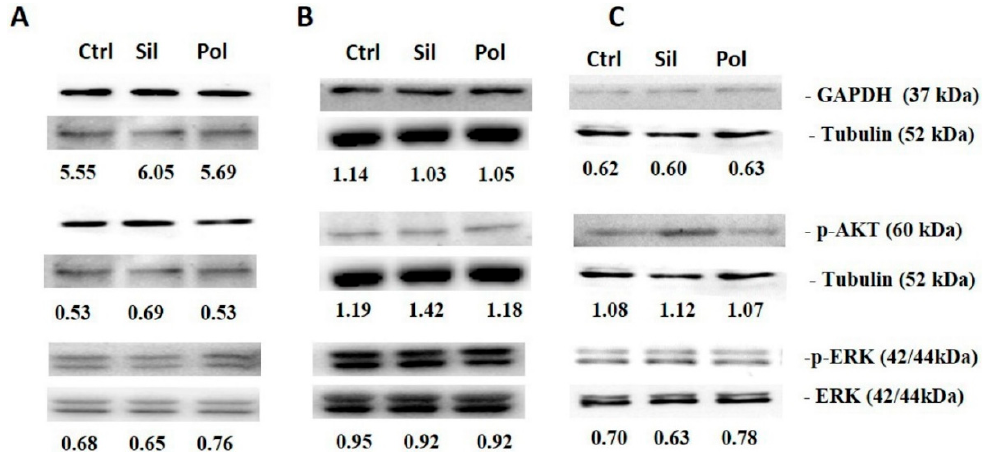
Figure 9. Nanoparticles e ff ects on non-tumor intracellular signaling. FGH, HUVEC and NGM cells were incubated with polymeric (pol) or silica(sil) nanoparticles (20 µ g / mL) for 24 h. Then, cell lysates were immunoblotted with anti-protein kinase R (PKR)-like endoplasmic reticulum kinase (PERK)–alpha 1 kinase 2(anti-pERK1 / 2) and anti-extracellular signal-regulated Kinase 1 / 2 (ERK1 / 2), anti-phospo-protein kinase B(pAKT) ser 473 and anti- protein kinase-B (AKT), anti- Glyceraldehyde 3-phosphate dehydrogenase(GAPDH) and anti-tubulin. ( A ). FGH ( B ). HUVEC ( C ). NGM. Results are presented as the mean ± SD calculated from three independent experiments (* p < 0,05).